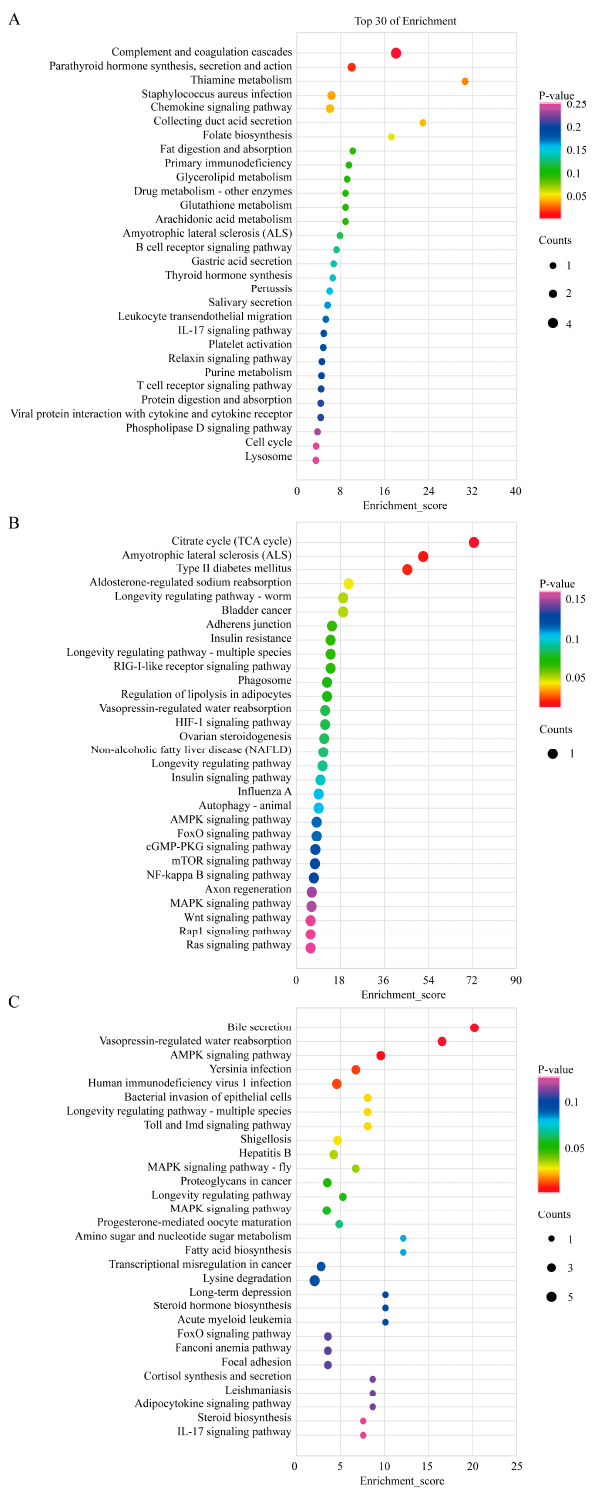
Figure 5. KEGG analysis of common DE genes. ( A ) KEGG analysis of common DE mRNAs. ( B ) KEGG analysis of common DE lncRNAs. ( C ) KEGG analysis of common DE circRNAs. The top 30 enriched KEGG terms ranked by p -values are shown ( p -value <